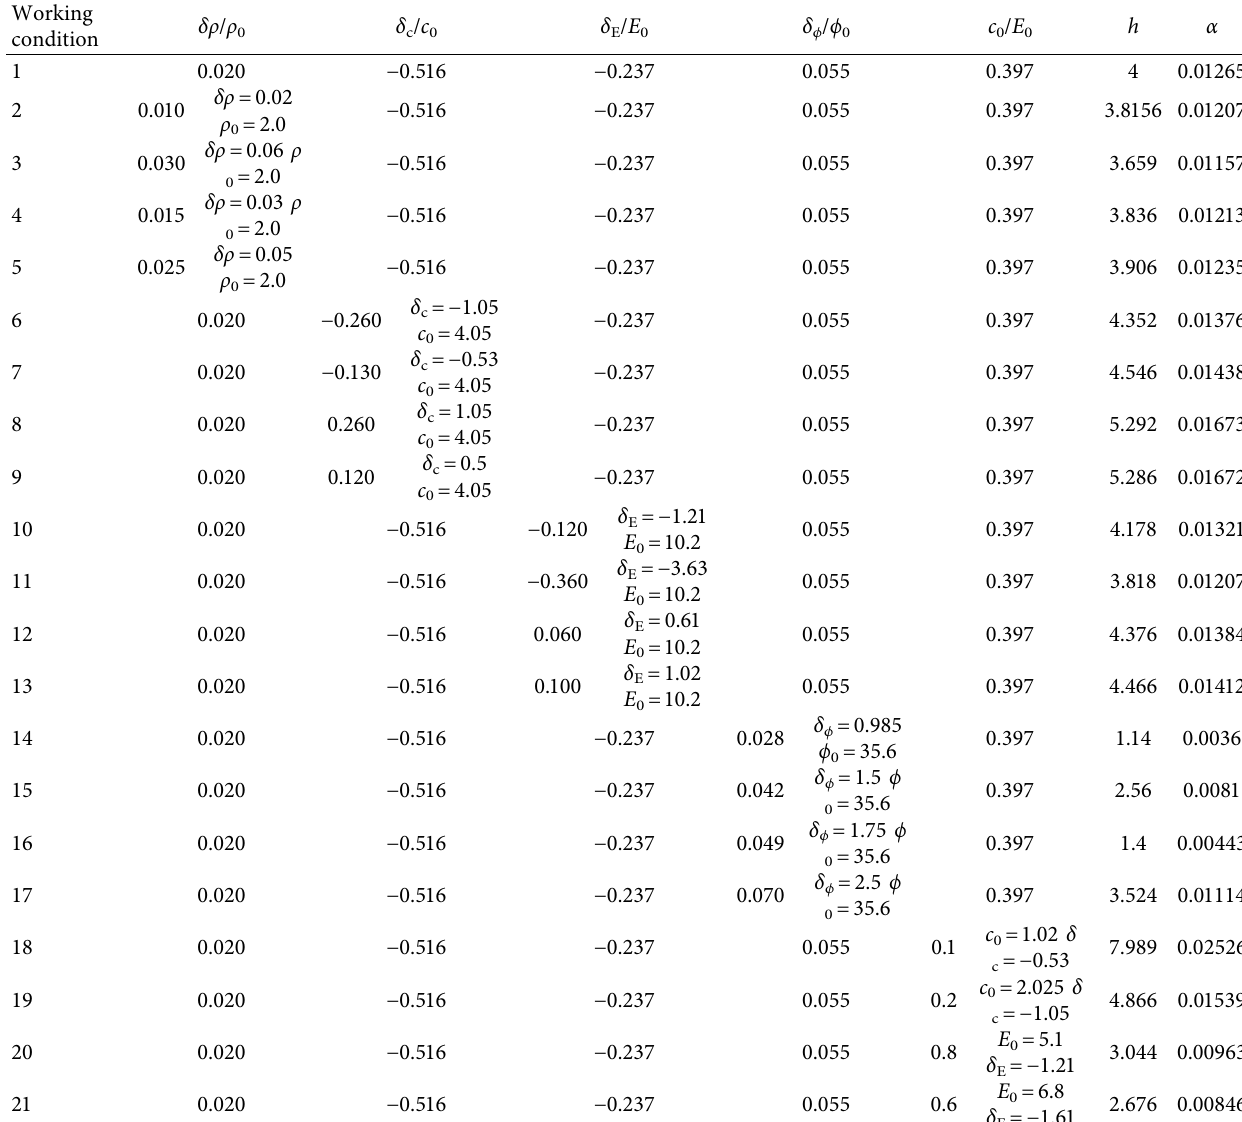
Table 2: Summary of calculation conditions.